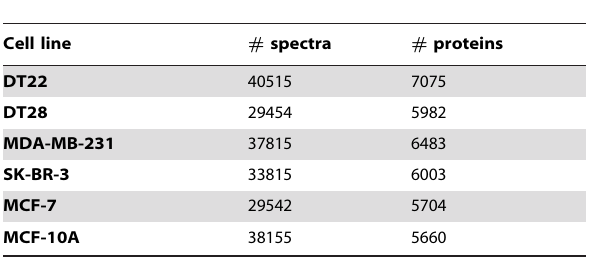
Table 1. Spectral count and protein totals.